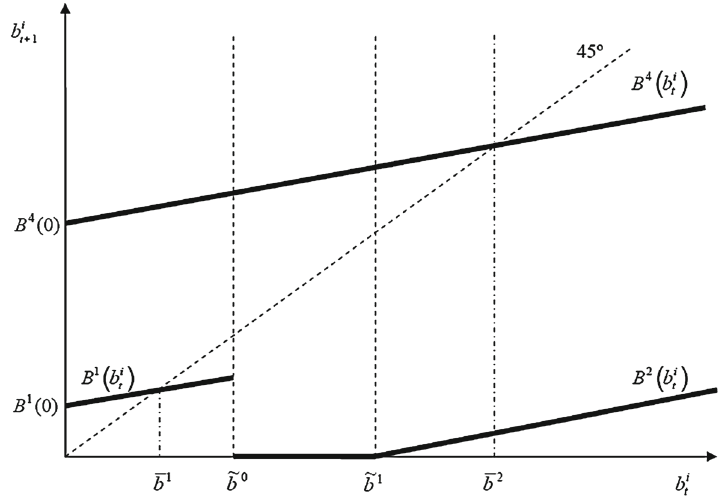
Fig. 4 The dynamics of bequests within a dynasty. (Source: Alonso-Carrera et al. 2012) = 1 educate their children if b i h i 0